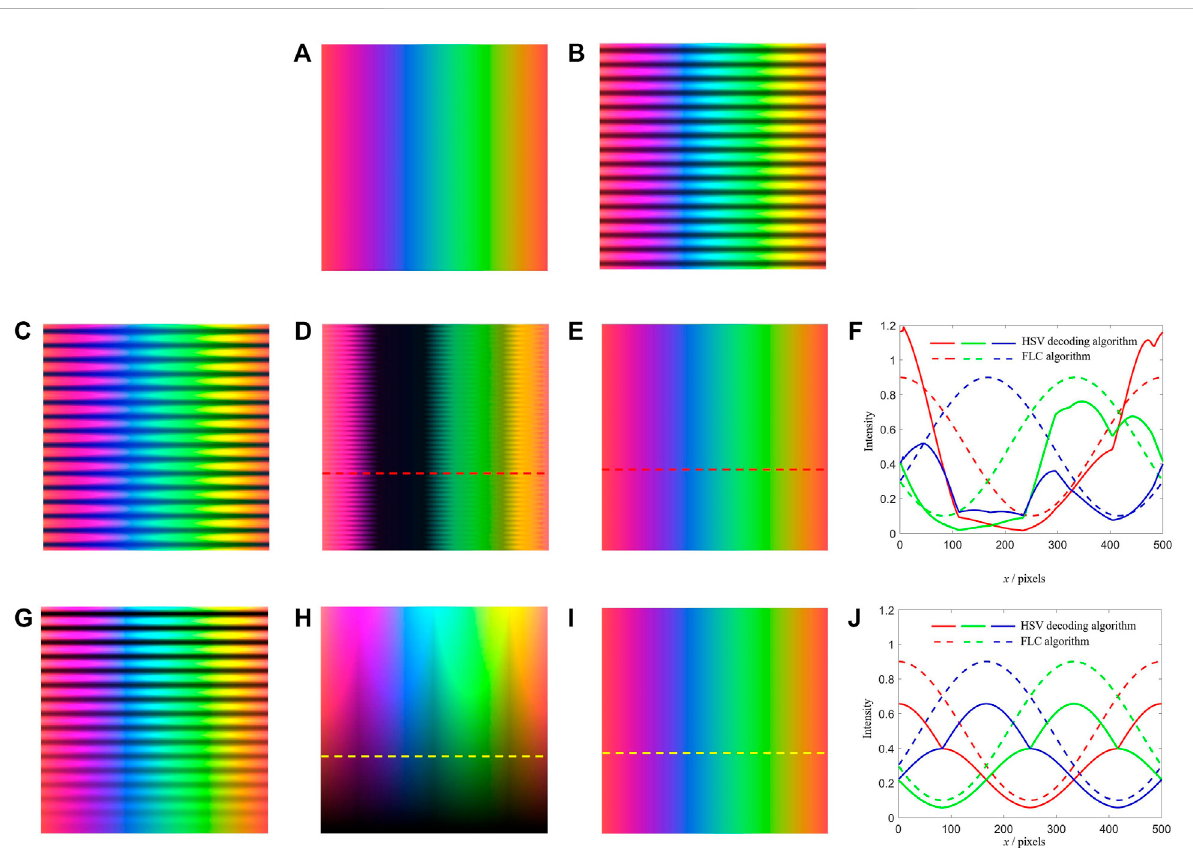
FIGURE 2 SimulationoftheHSVdecodingalgorithmandtheFLCalgorithminthispaper. (A) Rawimage. (B) Imageaddedwithnormalsinusoidalfringe. (C) Image added with sinusoidal fringe with chromatic aberration. (D) Image restored by the HSV decoding algorithm under chromatic aberration. (E) ImagerestoredbytheFLCalgorithmunderchromaticaberration. (F) IntensitycurveofR,G,andBalongthereddashedlinein (D,E) . (G) Imageadded withsinusoidalfringe withmodulationdepthvariation. (H) ImagerestoredbytheHSV decodingalgorithmundermodulationdepth variation. (I) Image restored by the FLC algorithm under modulation depth variation. (J) Intensity curve of R, G, and B along the yellow dashed line in (H,I)